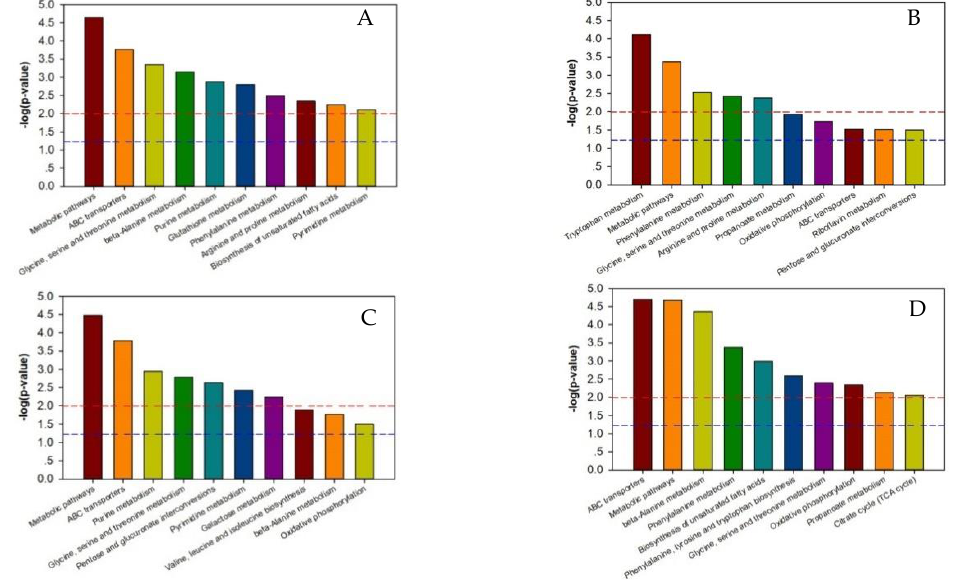
Figure 3. Enrichment map of metabolic pathways (top ten p -value) among test sample groups. Note: The dotted red line indicates a p -value of 0.01, while the dotted blue line indicates a p -value of 0.05. When the metabolite bars exceed the dotted red line or blue line, the corresponding signal pathways are significant. ( A ):B vs. BC; ( B ) BN vs. BNC; ( C ) BN vs. B; ( D ) BNC vs. BC. B is the Baiyu treatment group, B-C is the Baiyu control group, BN is the BaiyuN treatment group, BN-C is the BaiyuN control group.